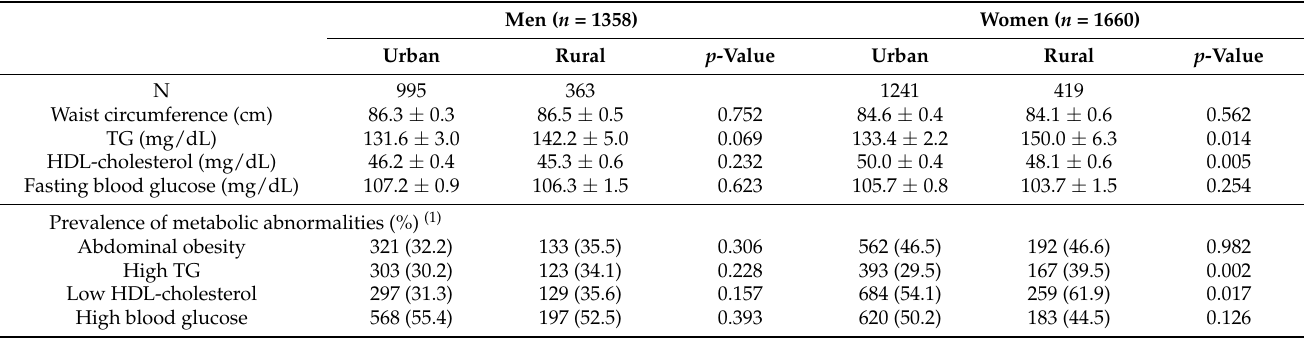
Table 2. Status of the metabolic abnormalities indicators of participants.